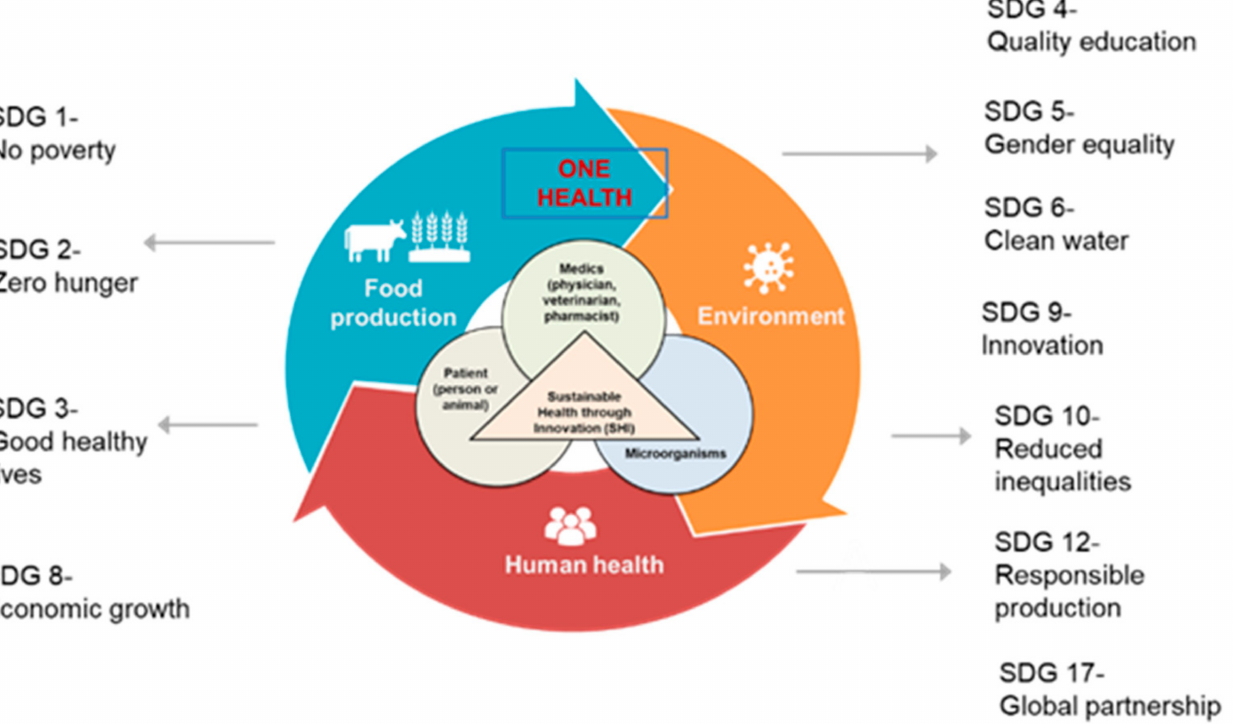
Figure 7. The SHI paradigm supporting the next generation of AMR network and its impact on 11 out of 17 SDGs (Some images were adopted from Google